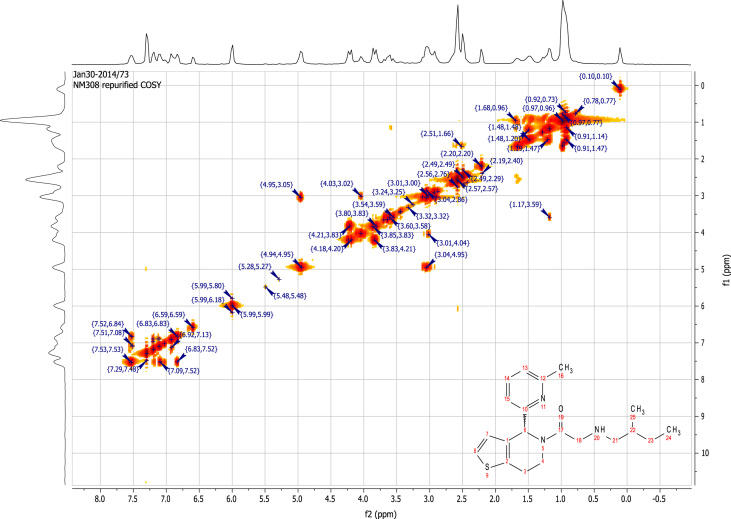
2D COSY (400 MHz,
CDCl3) of RU-SKI 201
(9d).